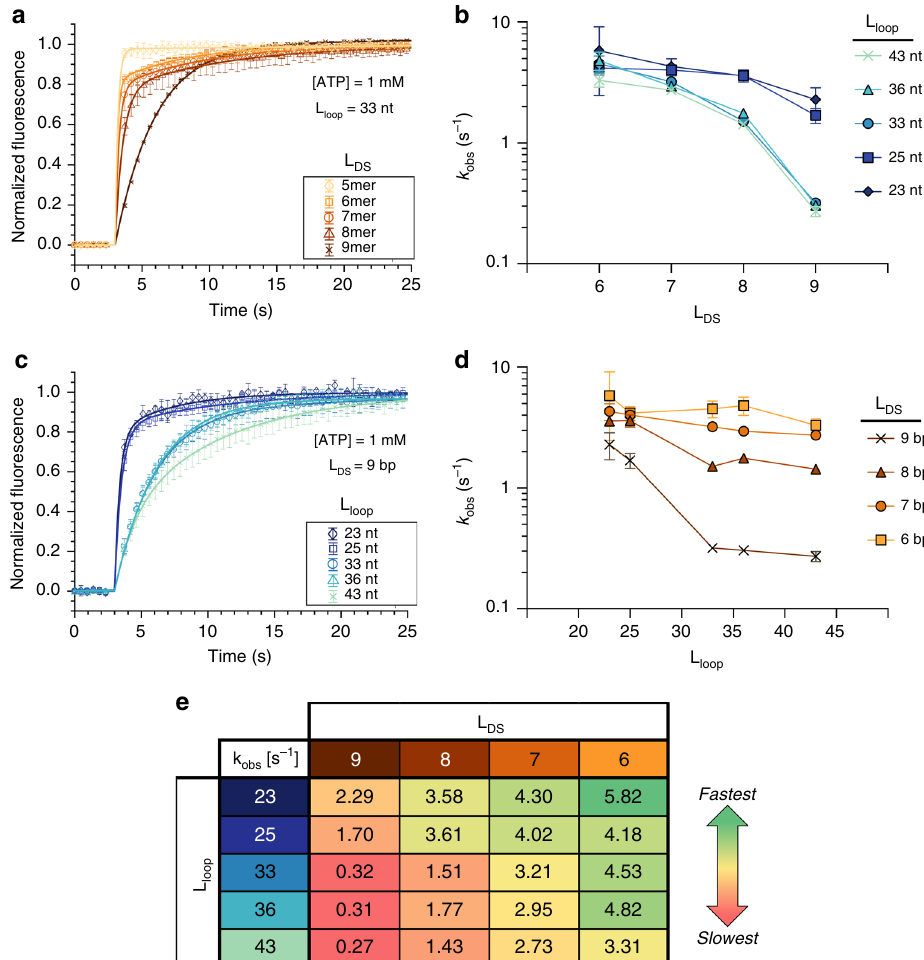
Fig. 4 Temporal response modulation via ISD switch design. a Normalized signal change upon injection of 1 mM ATP. Increasing L DS while holding L loop constant at 33 nt results in slower kinetics. b Effect on k obs of increasing L loop in an ISD construct with constant L DS in the presence of 1 mM ATP. c Normalized signal change upon injection with 1 mM ATP. Increasing L loop while keeping L DS constant at 9 results in slower kinetics. d Effect on k obs of increasing L DS in an ISD construct with constant L loop in the presence of 1 mM ATP. e k obs as a function of both L DS and L loop after injection with 1 mM ATP. Sequences with L DS = 5 had switching responses faster than the time resolution of our detector and could not be fi t accurately and have thus been omitted from panels b , d , and e . Error bars in a and c represent standard deviation ( n = 3), whereas those in b and d represent the 95% con fi dence intervals in the fi t parameter. Con fi dence intervals for e are listed in Supplementary Fig. 3. Source data are provided as a Source Data fi